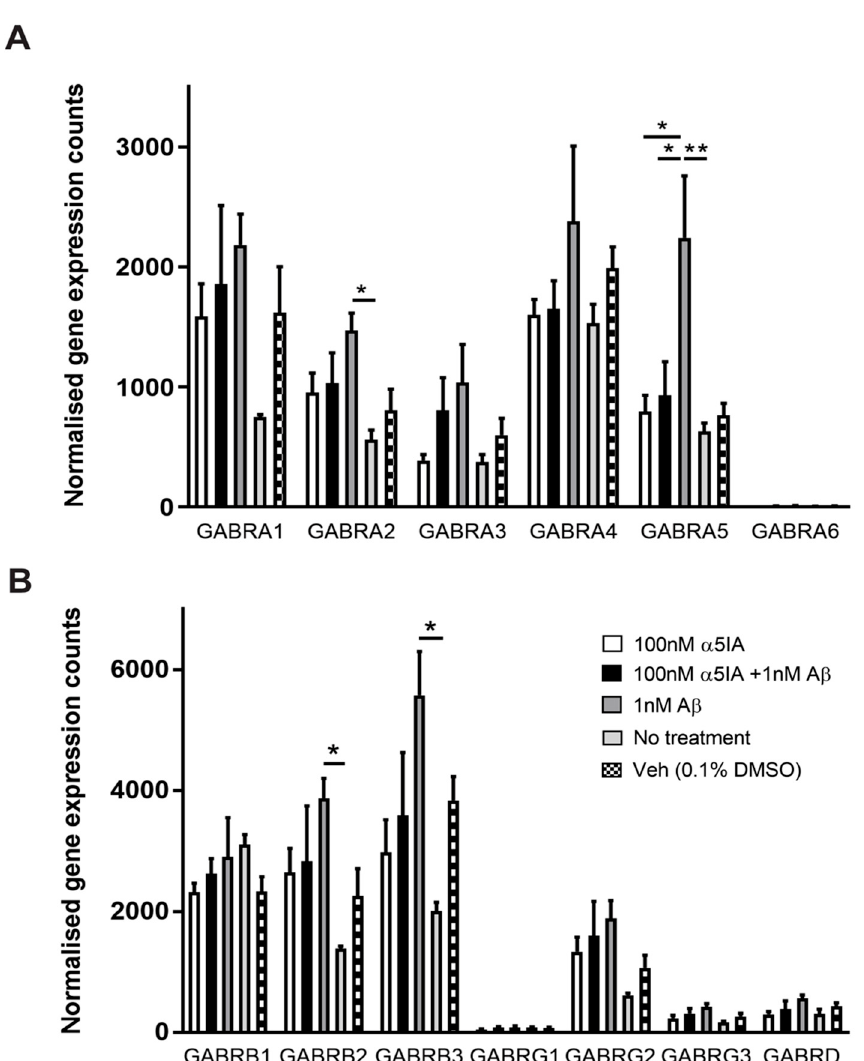
Figure 5. Expression of GABAergic signaling components in mouse primary hippocampal cultures 5 days after treatment with 100 nM α 5IA and/or 1 nM A β 1–42. A comprehensive analysis of changes in mRNA expression was performed using the NanoString nCounter gene expression assay. ( A ) Expression of GABAA receptor alpha subunits. ( B ) Expression of GABAA receptor beta, gamma, and delta subunits. Values are normalized to six housekeeping genes. Data is expressed as mean ± SEM. ** p < 0.01, * p < 0.05, compared to negative controls, One-way ANOVA with Bonferroni’s post hoc test for each gene. n = 4–5 for each experimental group.